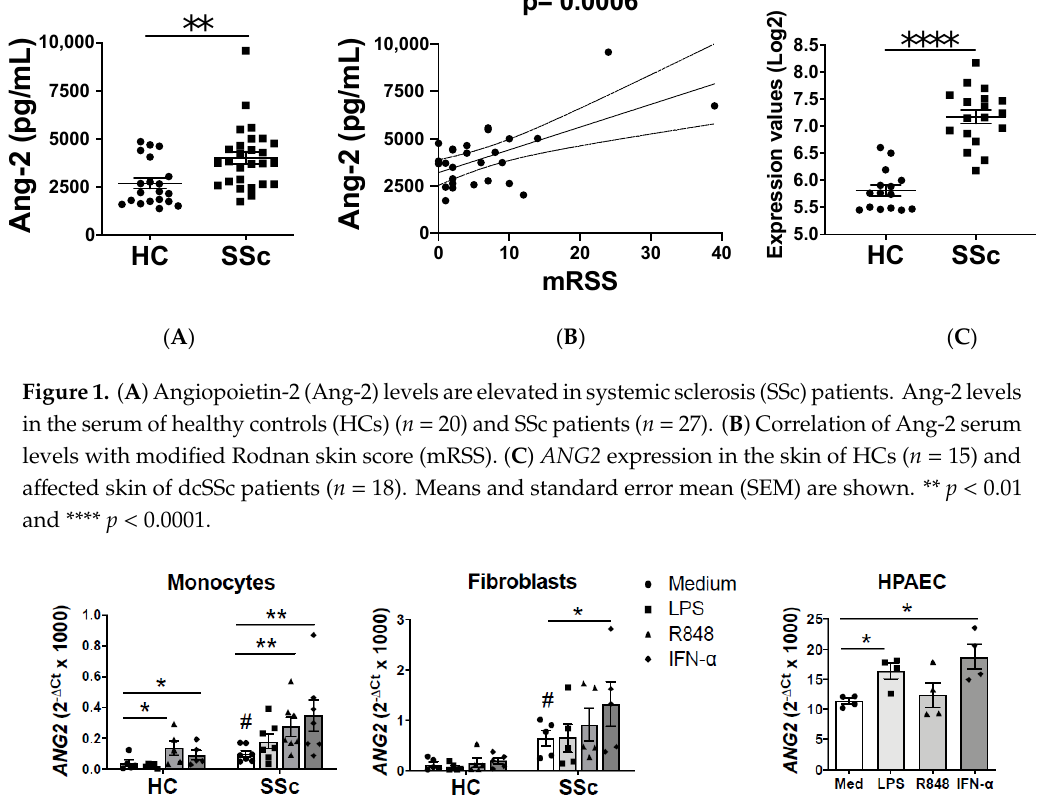
HCs ( n = 15) and affected skin of dcSSc patients ( n = 18). Means and standard error mean (SEM) are shown. ** p < 0.01 and **** p < 0.0001.